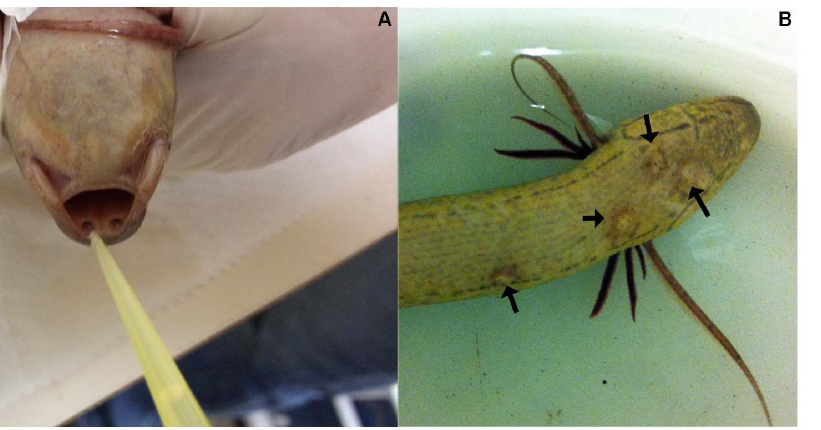
Figure 1. Experimental bacterial infection model in P.dolloi . A) Delivery of E. ictaluri to P. dolloi intranasally. B) Skin ulcers (black arrows) produced by E. ictaluri in an infected P. dolloi individual. No ulcers were observed in control specimens.